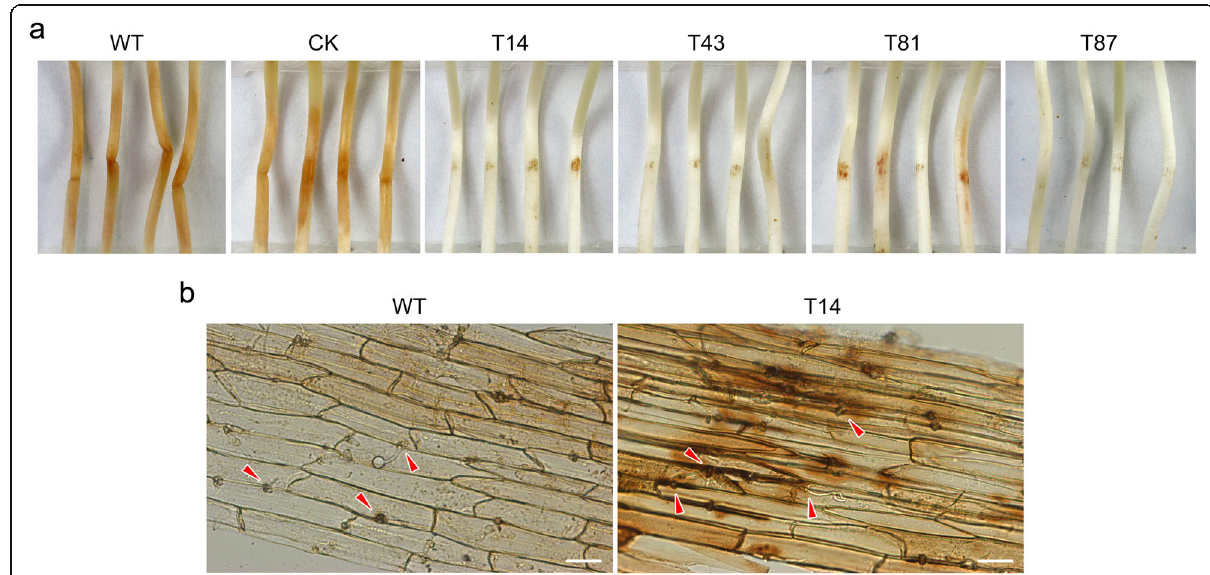
Fig. 3 Pathogenicity was attenuated in PsBZP32 -silenced transformants. a Etiolated seedlings of the susceptible soybean cultivar Hefeng47 were inoculated with zoospores of the WT and PsBZP32 -silenced transformants and photographed at 36 hpi. b ROS accumulation in hypocotyls inoculated with zoospores of P. sojae (WT and PsBZP32 -silenced transformant T14 as examples) at 12 hpi by DAB staining. Red arrows indicate infected hyphae. Bar, 50 μ